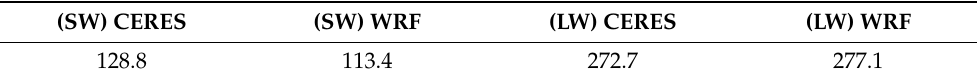
Table 8. Full domain and whole period averages of shortwave (SW) and longwave (LW) radiative fluxes at the top of the atmosphere (TOA) by CERES and WRF-Chem. Units are Wm − 2 . (SW)